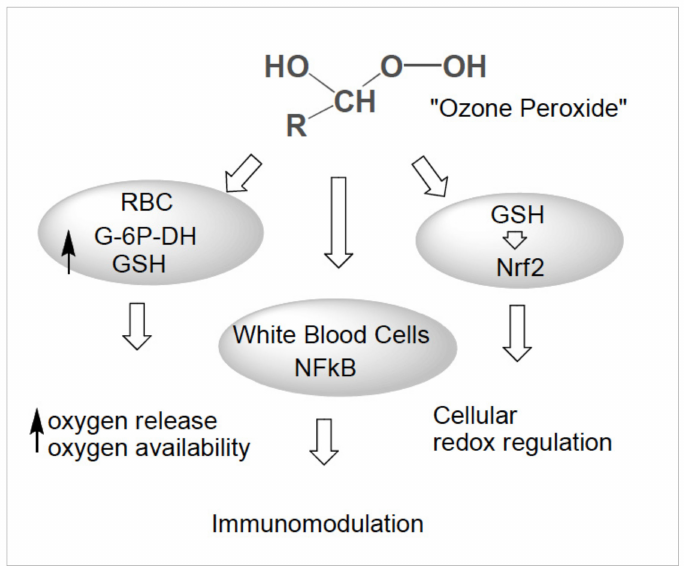
Figure 5. The pharmacological effects of medical ozone via ozone-produced peroxides. The three ef- fects: 1. improved oxygen release by the red blood cells (RBC) through activation of RBC metabolism. 2. Immunomodulation through activation of the white blood cells (WBC) and signal transduction via nuclear factors. 3. Regulation of cellular antioxidants via Nrf2 signalling [9].